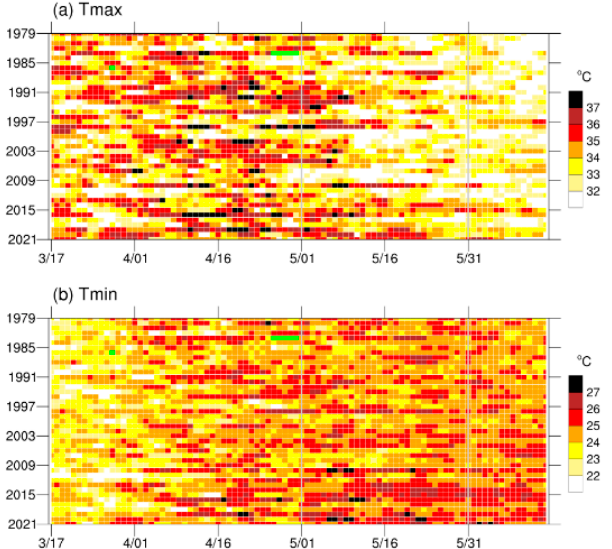
Figure 2. The temporal variations of daily ( a ) maximum and ( b ) minimum surface temperatures averaged over the ICP region, as shown in Figure 1a. The vertical axis is the 43-year period from 1979 to 2021, and the horizontal axis is the 90-day span of calendar days from 17 March to 14 June, with the color representing the temperature value for a day of the year. The green color indicates a missing record. Vertical gray lines indicate 1 May and 31 May, respectively.